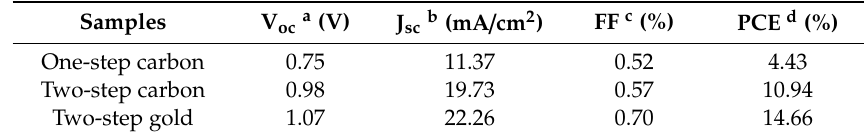
Photovoltaic detailed parameters of perovskite devices prepared by one-step and two-step methods.